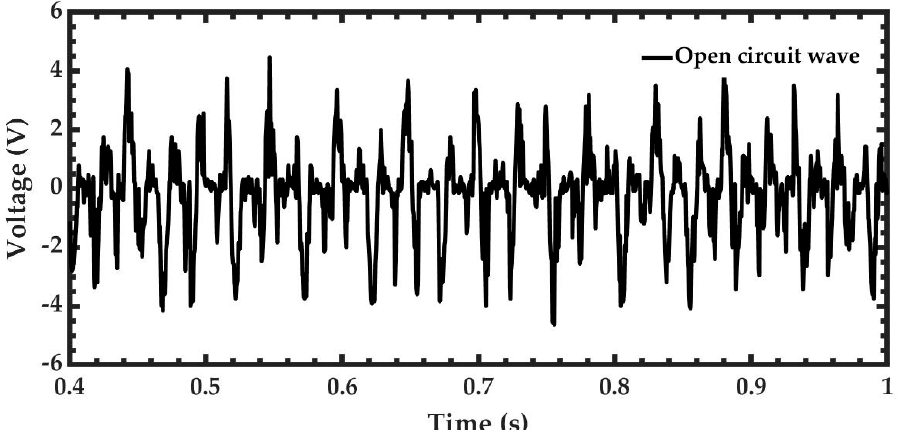
Figure 7. Schematic view of the short circuit (Vsc) characterization system of the flexible pVEH microdevice.